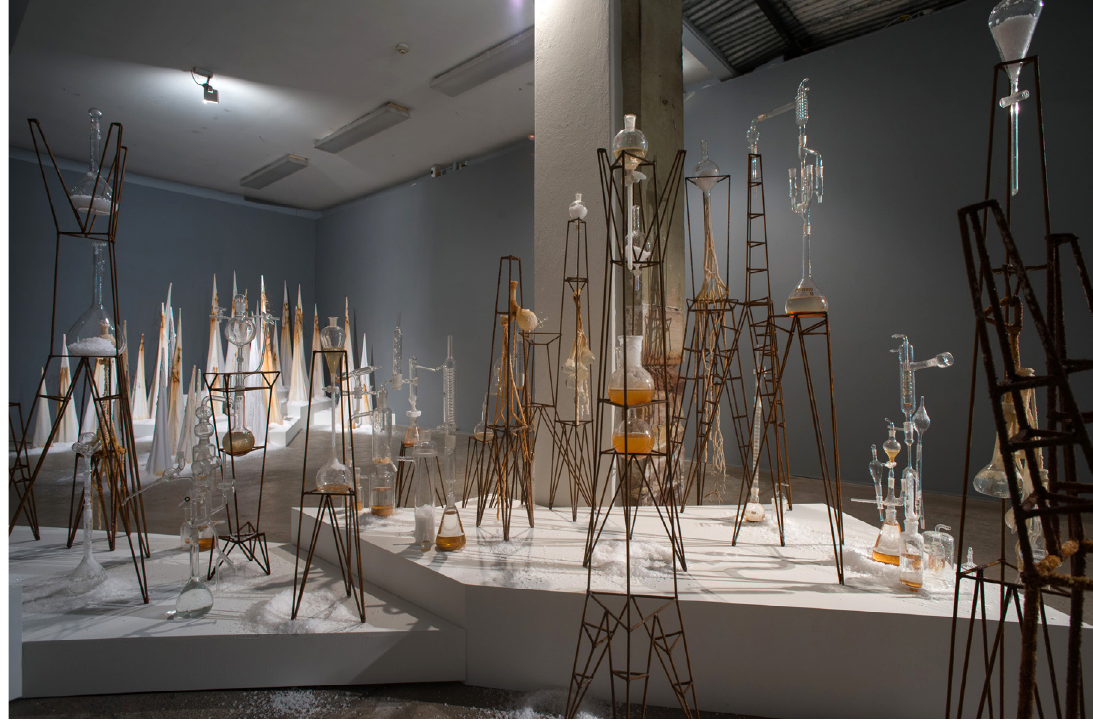
Figure 6: Tracey Clement, Metropolis Experiment , 2016-18, rusty steel, lab glass, salt, cotton, dimensions variable, max height 200 cm. Metropolis Experiment is clearly a science experiment gone horribly wrong; the methods of science